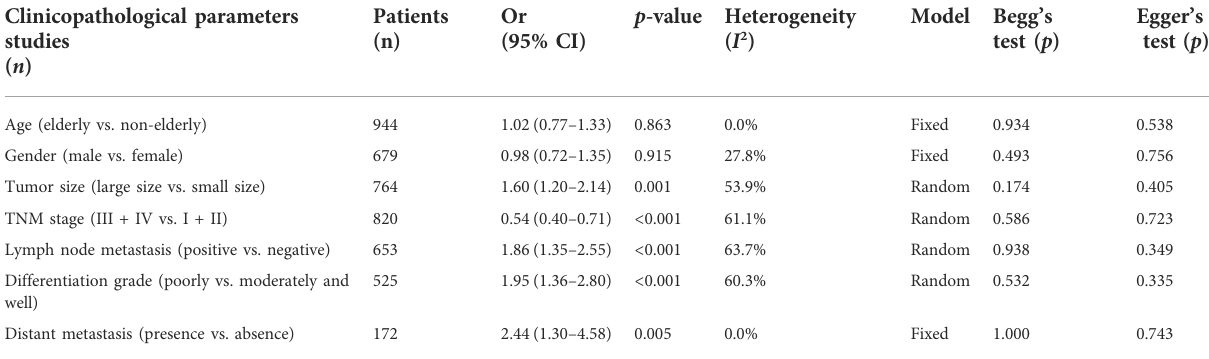
TABLE 3 Result of SNHG14 expression with clinicopathological feature.